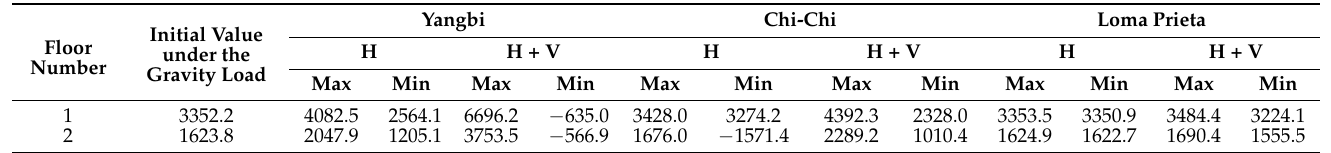
Table 9. The maximum and minimum axial force at the bottom of brick masonry walls of each